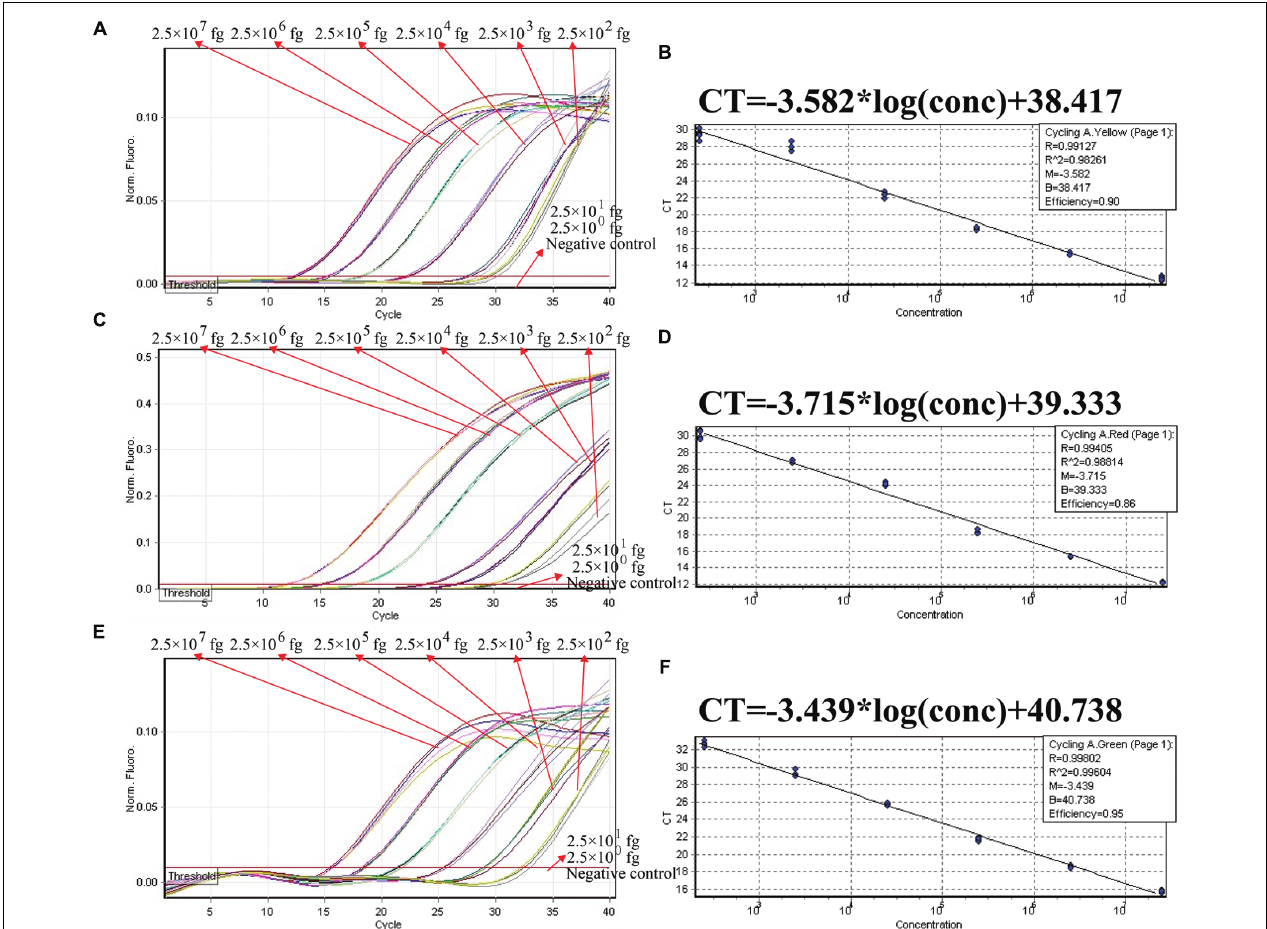
FIGURE 7 | The analytical sensitivity of ET-PCR assay for simultaneously detecting three targets. Three sets of ET-PCR primer targeting ply , nuc, and Ef0027 genes were used in the same reaction. (A) , (C), and (E) were simultaneously yielded from HEX (labeling EF of ply ), Cy5 (labeling EF of nuc ), and FAM (labeling EF of Ef0027 ), respectively. The DNA levels from 2.5 × 10 7 to 2.5 × 10 2 fg per tube provide the positive signals, 2.5 × 10 1 and 2.5 × 10 0 fg per reaction and negative control generate negative signal. ( B ; S. pneumoniae ), ( D ; S. aureus ), and ( F ; E. faecalis ), C t was plotted against the sample DNA concentration (fg) of the